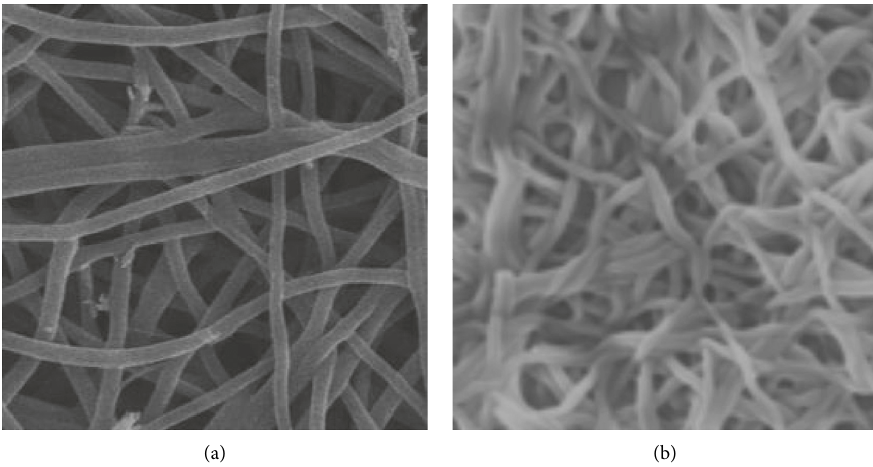
Figure 7: SEM photos: (a) SEM photos of polyacrylic alcohol glutaraldehyde nanofibers obtained by electrospinning and (b) SEM photos after soaking in the acid solution for 12 days and drying and soaking in double distilled water for 1